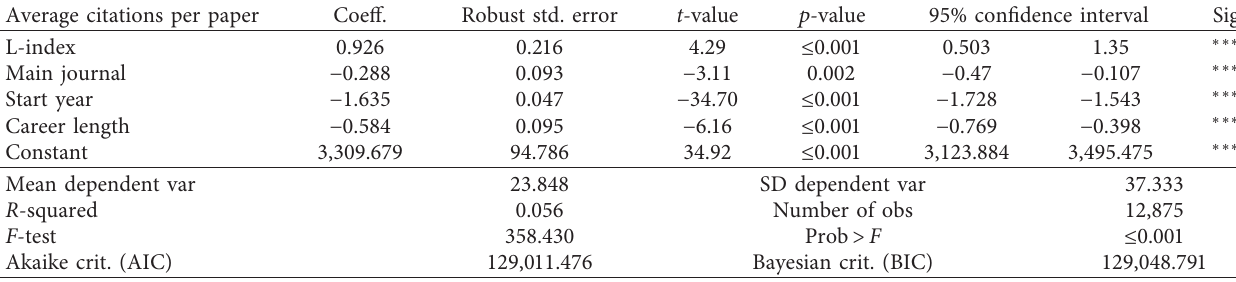
Table 6: Unary linear regression results of average citations per paper and L-index.